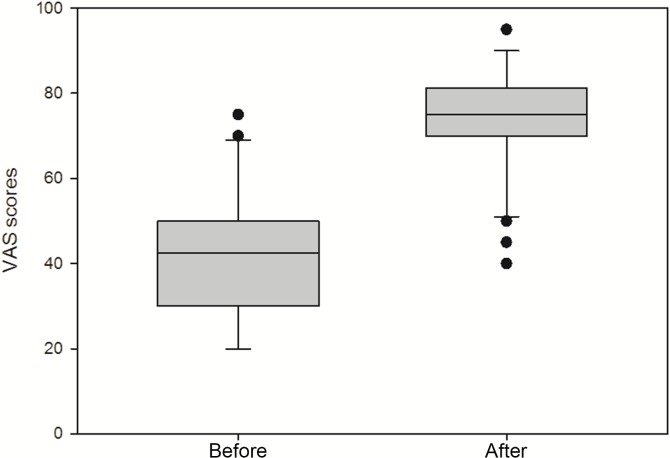
Graphical presentation of health status of patients by a Visual Analogue Scale (VAS).Box plots illustrating significantly lower self-rated health status of patients with hyperthyroidism (Before) as compared to euthyroid patients (After) by VAS scoring.